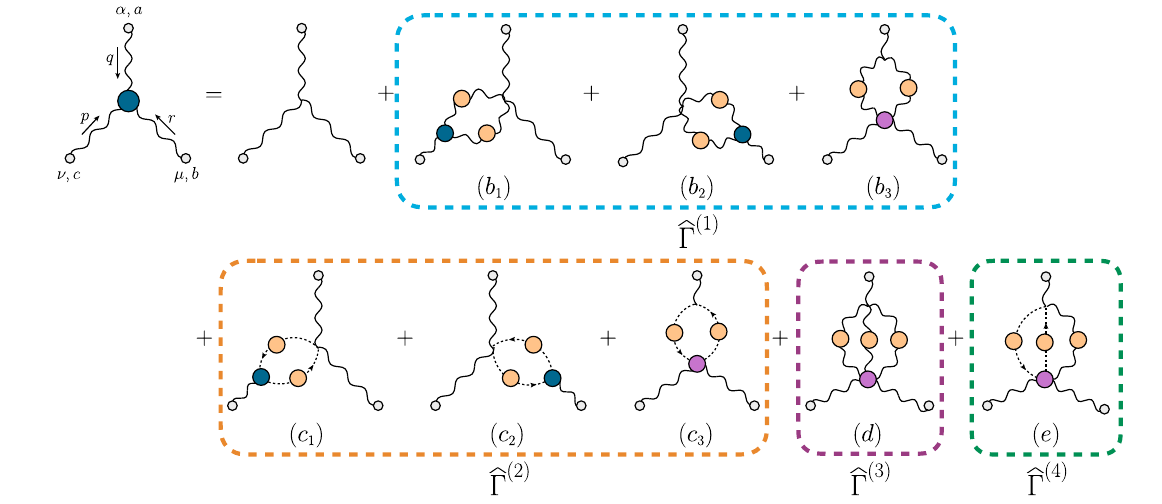
Fig. 2 Theblock-wisestructureoftheSDEwhichdescribesthethree-gluonvertex (cid:2) (cid:2) abc αμν ( q , r , p ) (BBB).Thebluecirclesrepresentfullone-particle irreducible vertices, while the purple ones the four- and five-point scattering kernels